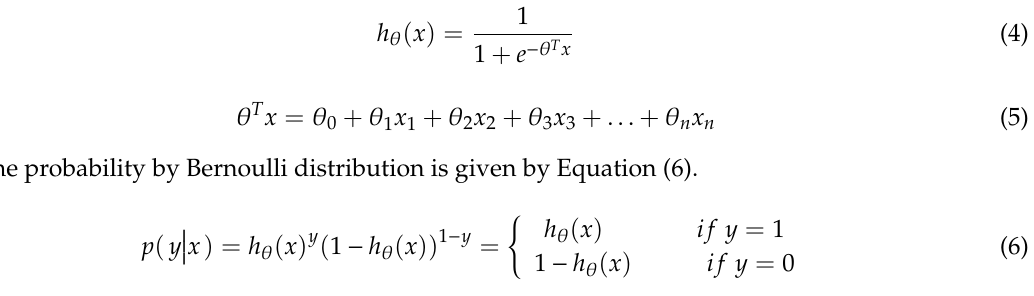
Figure 2. Data processing architecture of the k General Regression Neural Networks by using a Genetic Algorithm.